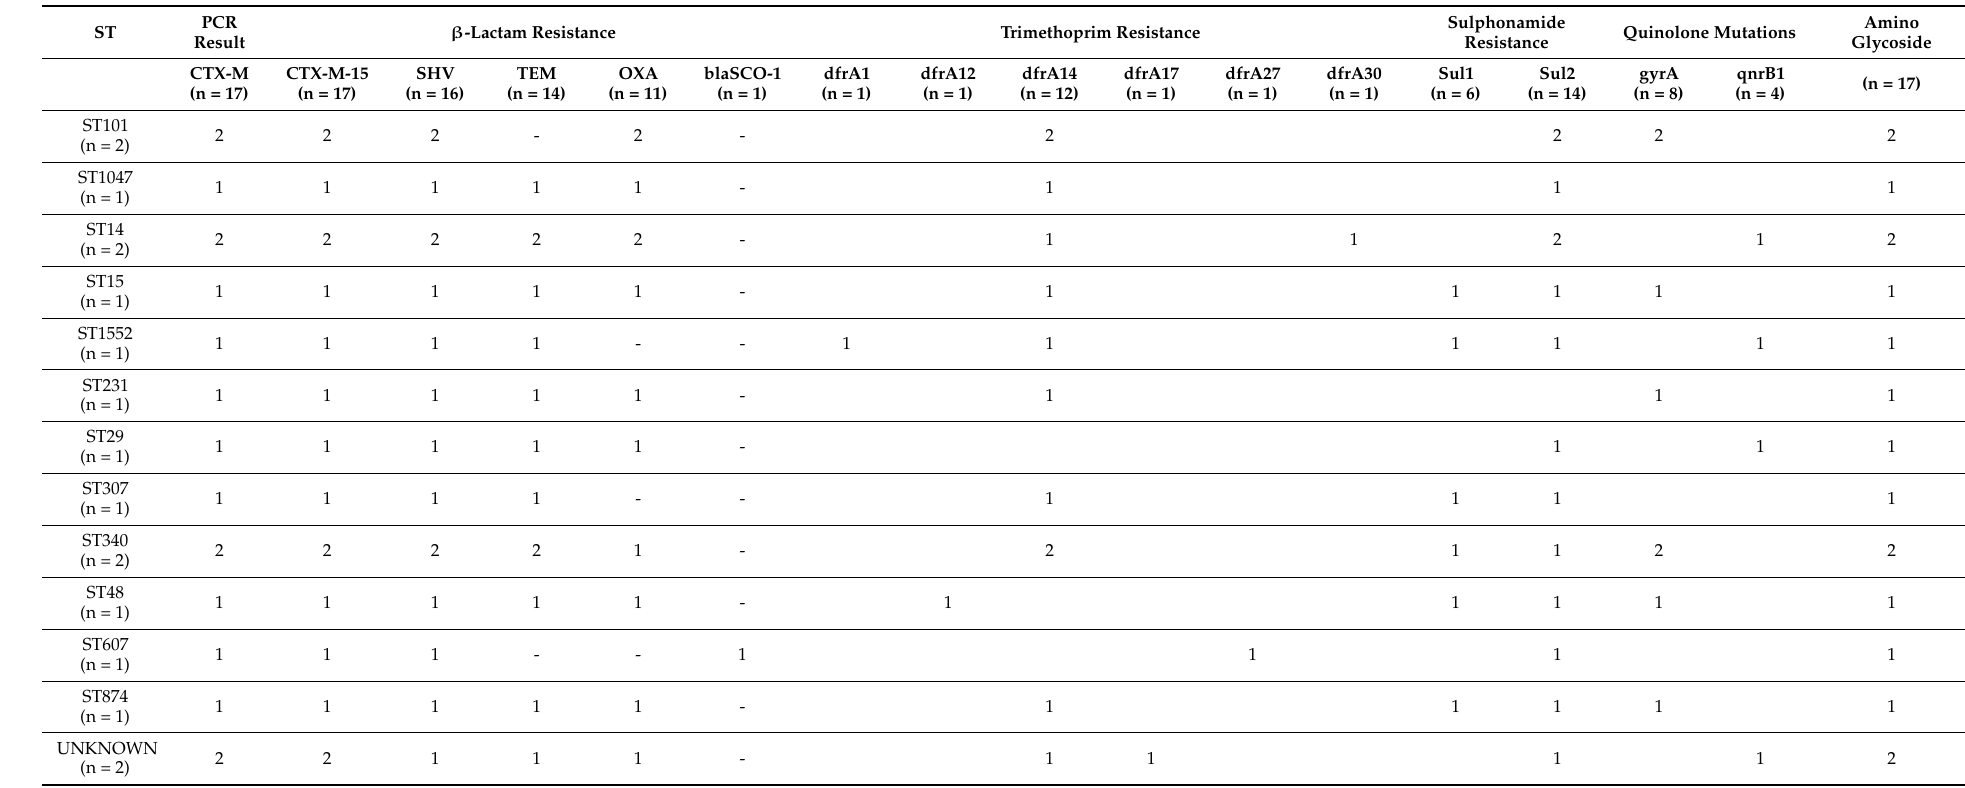
Table 2. ST-distribution and clinical important antimicrobial resistance determinants in K. pneumoniae strains (n =